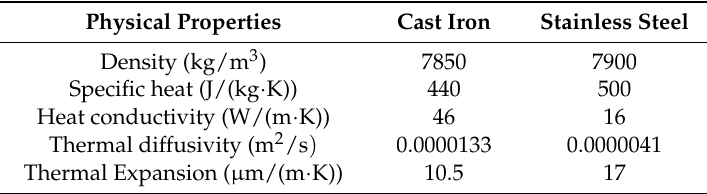
Table 4. Material parameters of stainless steel and cast